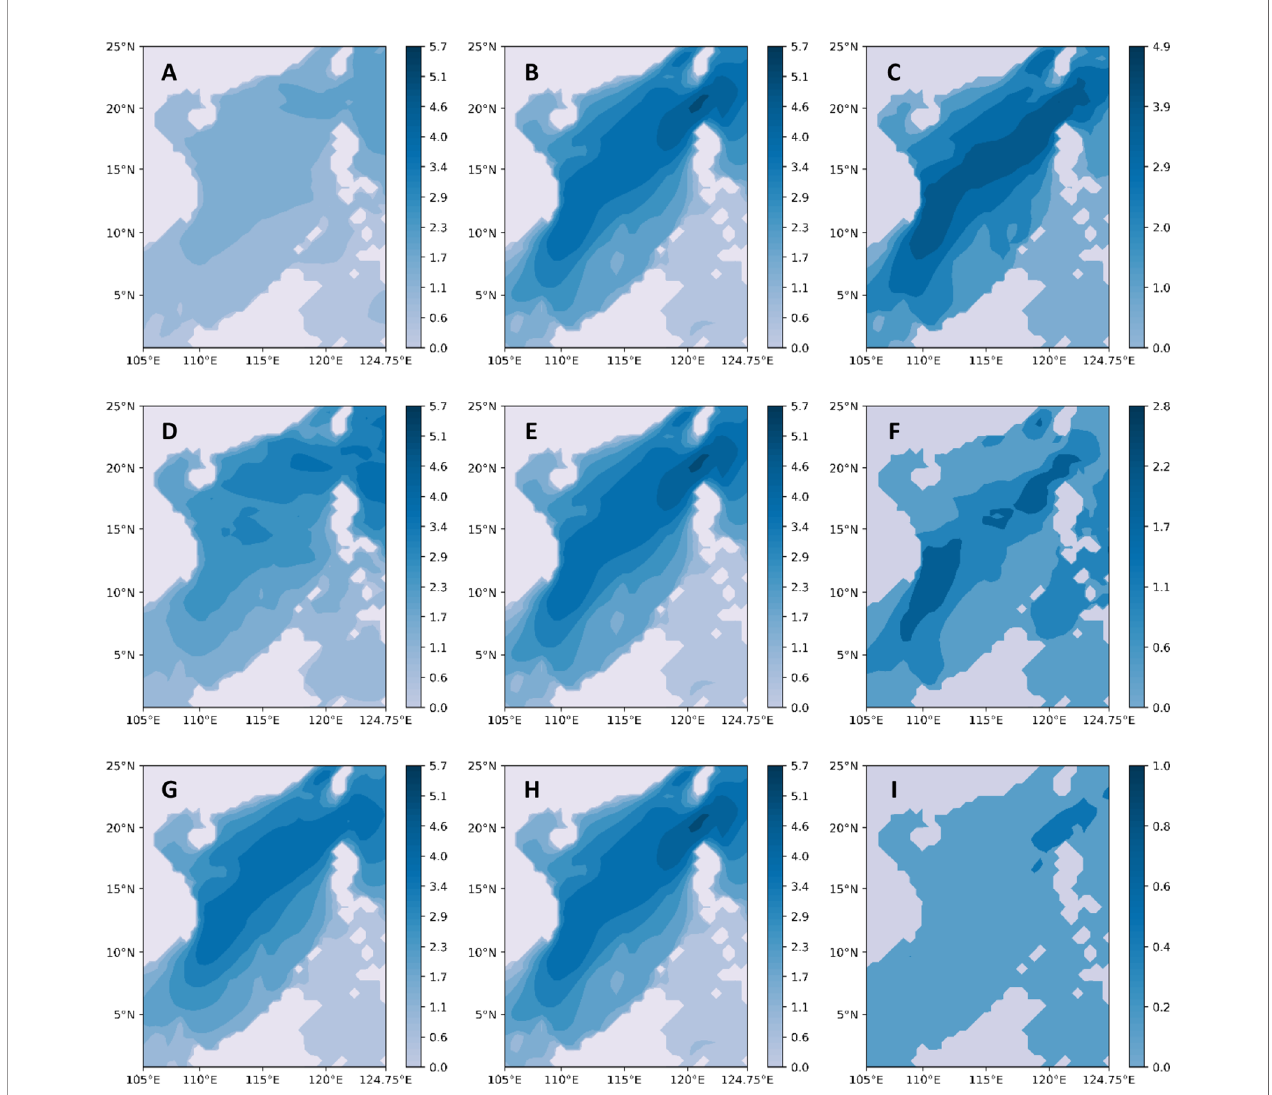
FIGURE 8 | Continuous prediction for one-day prediction. (A – C) are the prediction results of the CNN model, the ERA5 data results, and the prediction errors, respectively. (D – F) are the prediction results of the CNN + Bi-LSTM model, the ERA5 data results, and the prediction errors, respectively. (G – I) are CBA-Net model prediction results, ERA5 data results, and prediction errors,